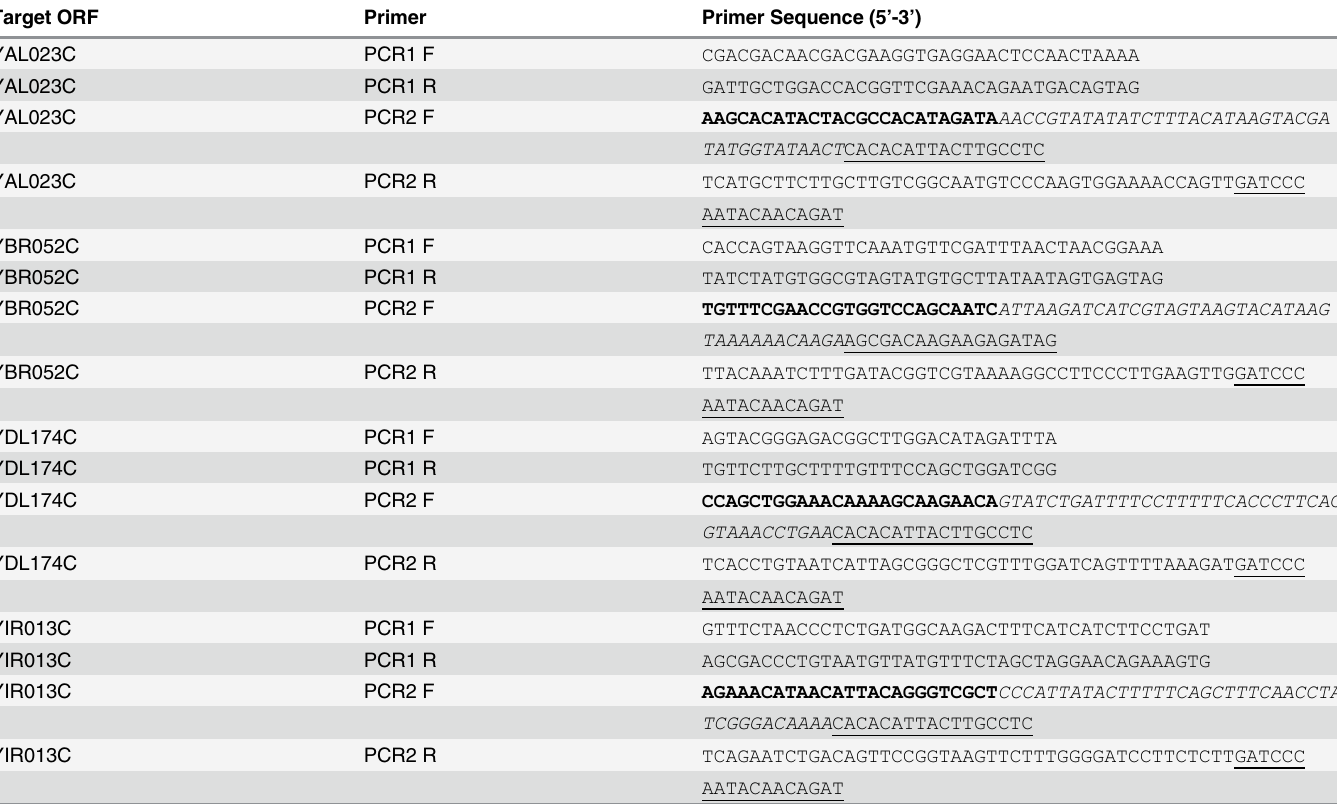
Table 1. Primer sequences used to delete four candidate genes. The PCR2_F primer is chimeric and is composed of three different parts. The bold font sequence is the region that overlaps with the PCR1 product, the italicised region represents the 40 nucleotide recombination sequence (R region) and the underlined sequence is complementary to the start of the marker gene. The PCR2_R primer consists of two parts, a region that is homologous to the target region and a region that is complementary to the marker gene